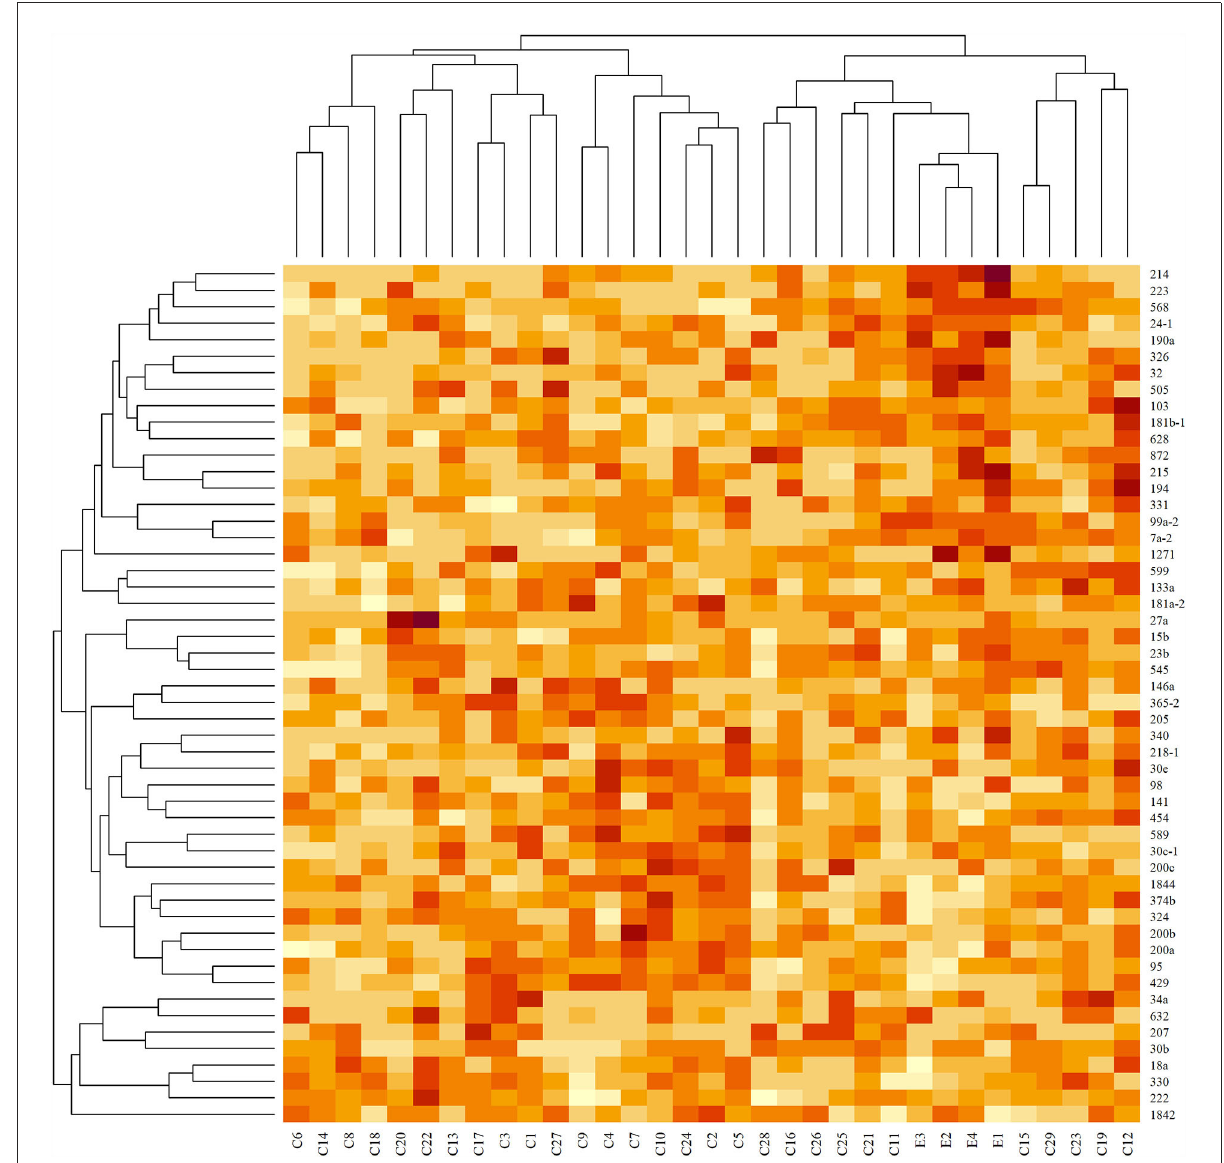
FIGURE2 Heatmap of standardized read counts for filtered miRNA subset. Darker colors correspond to higher read counts. Dendrograms were derived with agglomerative hierarchical clustering with Pearson’s correlation distance and average linkage. Tissue samples are labeled along the x-axis, and miRNA samples are labeled along the y-axis. Increased expression of miR-214, miR-223, miR-568, miR-24-1, miR-2901, and miR-32 are seen in the control samples (E) compared to invasive urothelial carcinoma samples